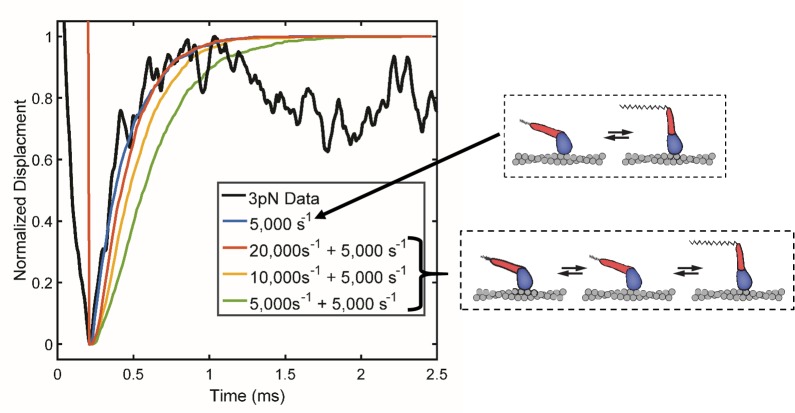
Simulations of the initial ensemble displacement for immediate (blue) vs. multistep processes (red, yellow, green) occurring between actin binding and the working stroke compared to the observed data at 3 pN load (black).Only the single process at 5000 s−1 (blue) or a multistep reaction scheme with one rate being ≥10,000 s−1 (red and yellow) exhibit rapid displacement stroke like that observed (black). This comparison indicates that if extra processes occur between binding and completion of the working, they must be extremely fast. The high speed of the stroke thus rules against extra reaction steps.